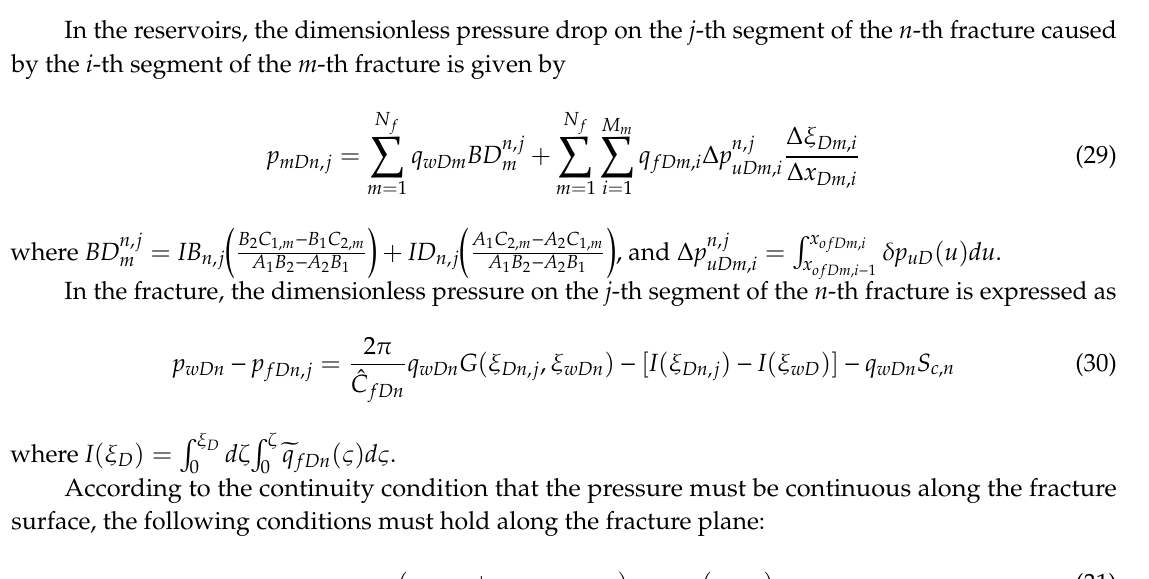
Figure 6. Illustration of dimension transformation and fracture discretization.